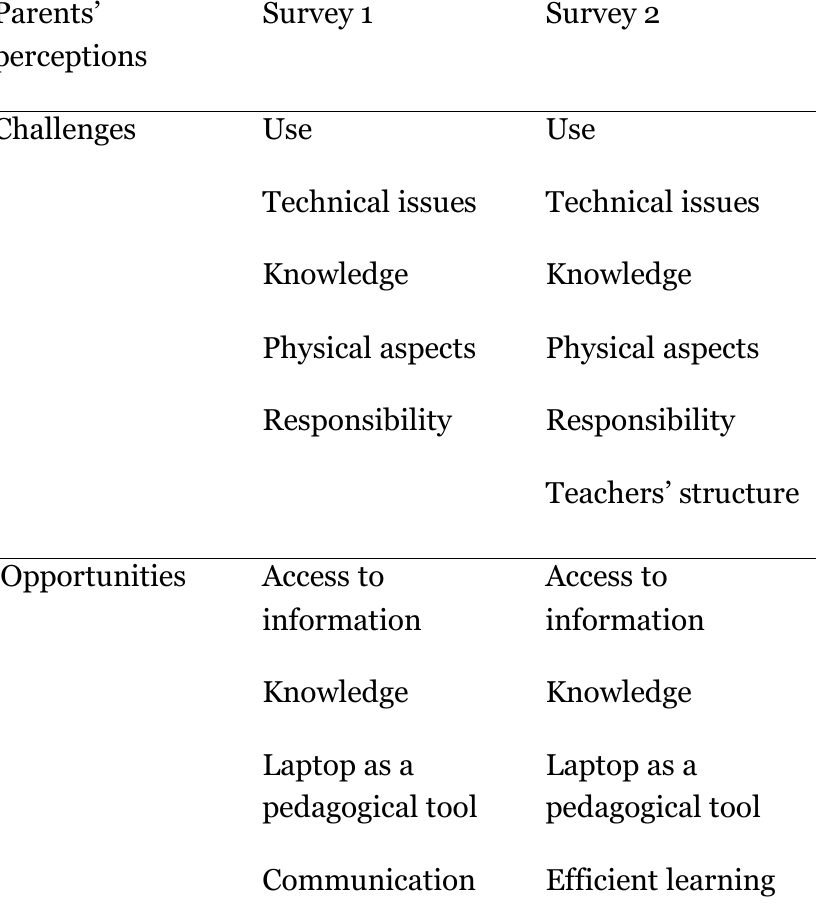
Table 7 Parents’ perceptions of challenges and opportunities from Survey 1 to Survey